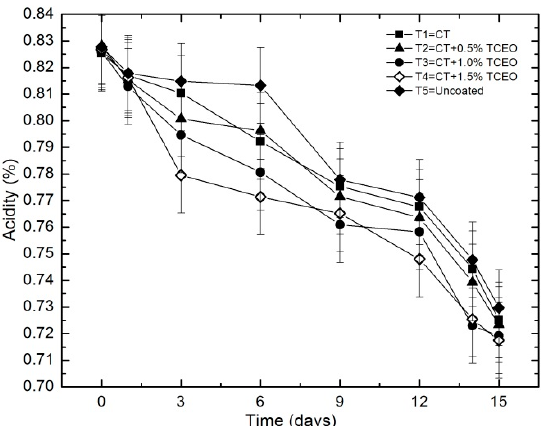
Figure 4. Evolution of the percentage of titratable acidity expressed as citric acid in strawberries with chitosan (CT) and treatments of oil (TCEO): T1 = CT, T2 = CT + 0.5% of TCEO, T3 = CT + 1.0% of TCEO, T4 = CT + 1.5% TCEO, and T5 = uncoated. Mean values and intervals of Fisher’s LSD of 95% according to the ANOVA test.